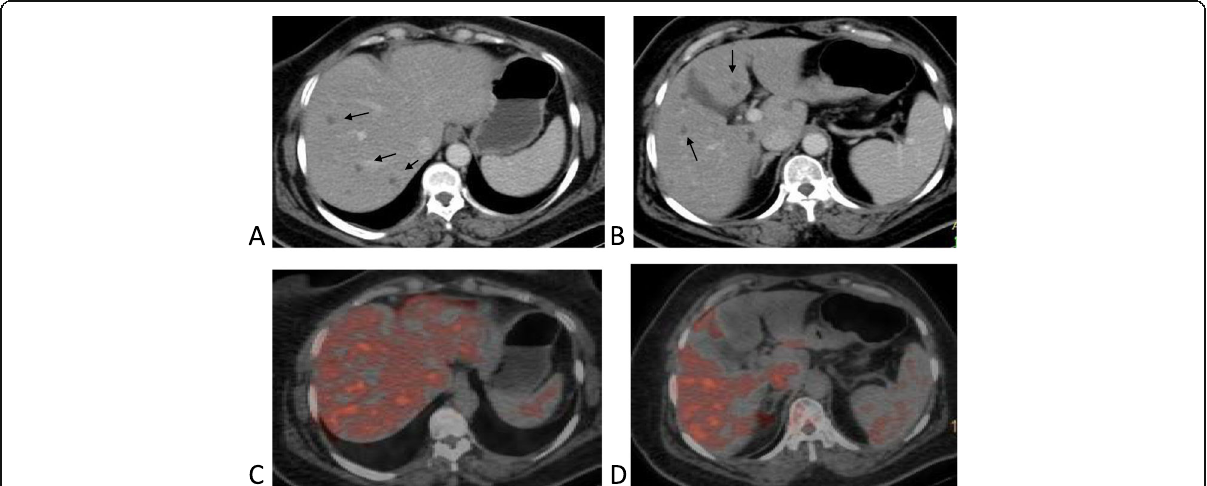
Fig. 4 A 40-year-old male patient who underwent rectal resection for pathologically proven mucinous adenocarcinoma, not followed by chemo or radiotherapy. Follow-up revealed elevated level of tumor markers. a , b Axial post-contrast CT images showing multiple small sized hypodense non-enhancing hepatic focal lesions (arrows). c , d Axial fused PET/CT images showing no avid metabolic hepatic focal lesions at the same levels